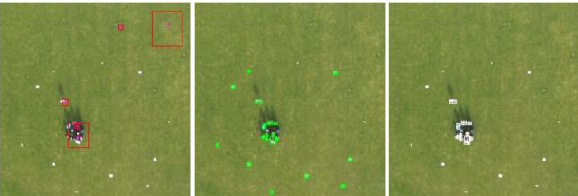
Figure 10. Results of the detection algorithms for the same video frame: thermal image only (left), RGB image only (middle) and fused information